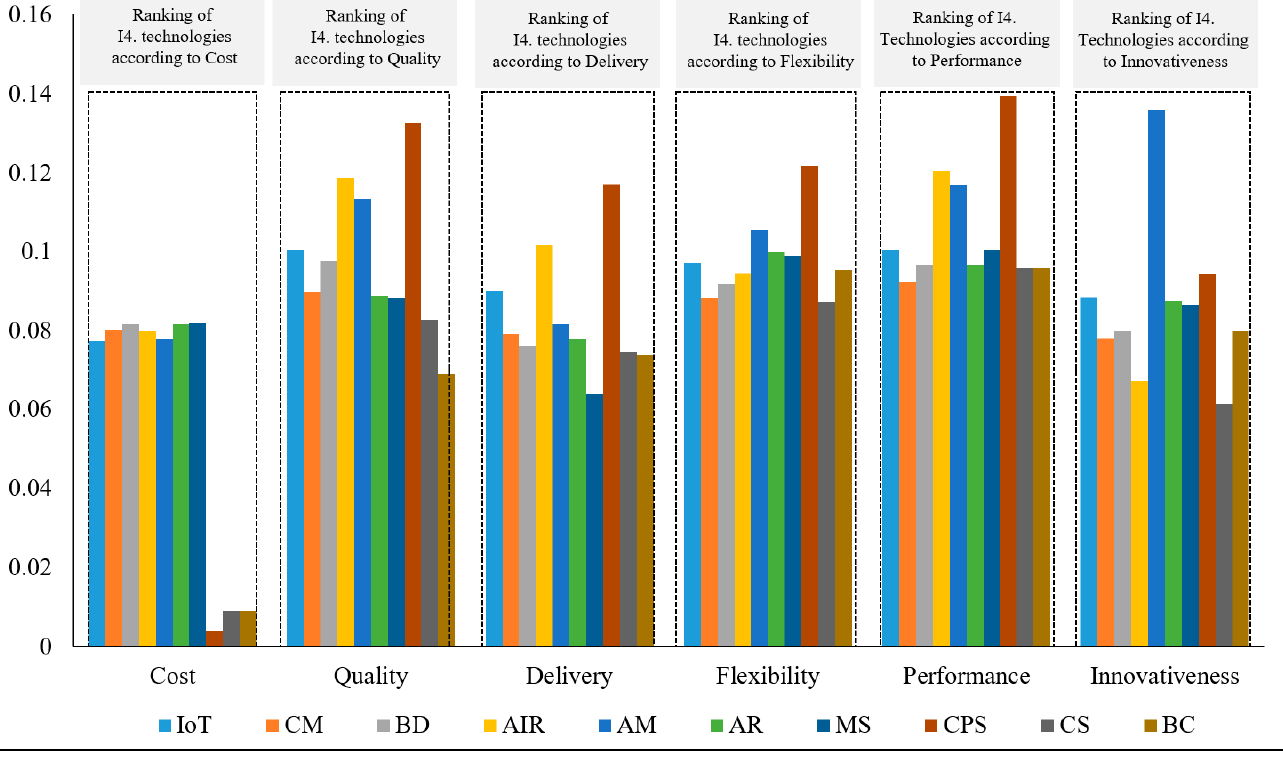
Table 13. Comparisons between previous results and current findings considering I4.0 technologies